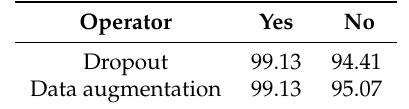
Table 8. OA of Bi-CLSTM on the KSC dataset with and without dropout and data